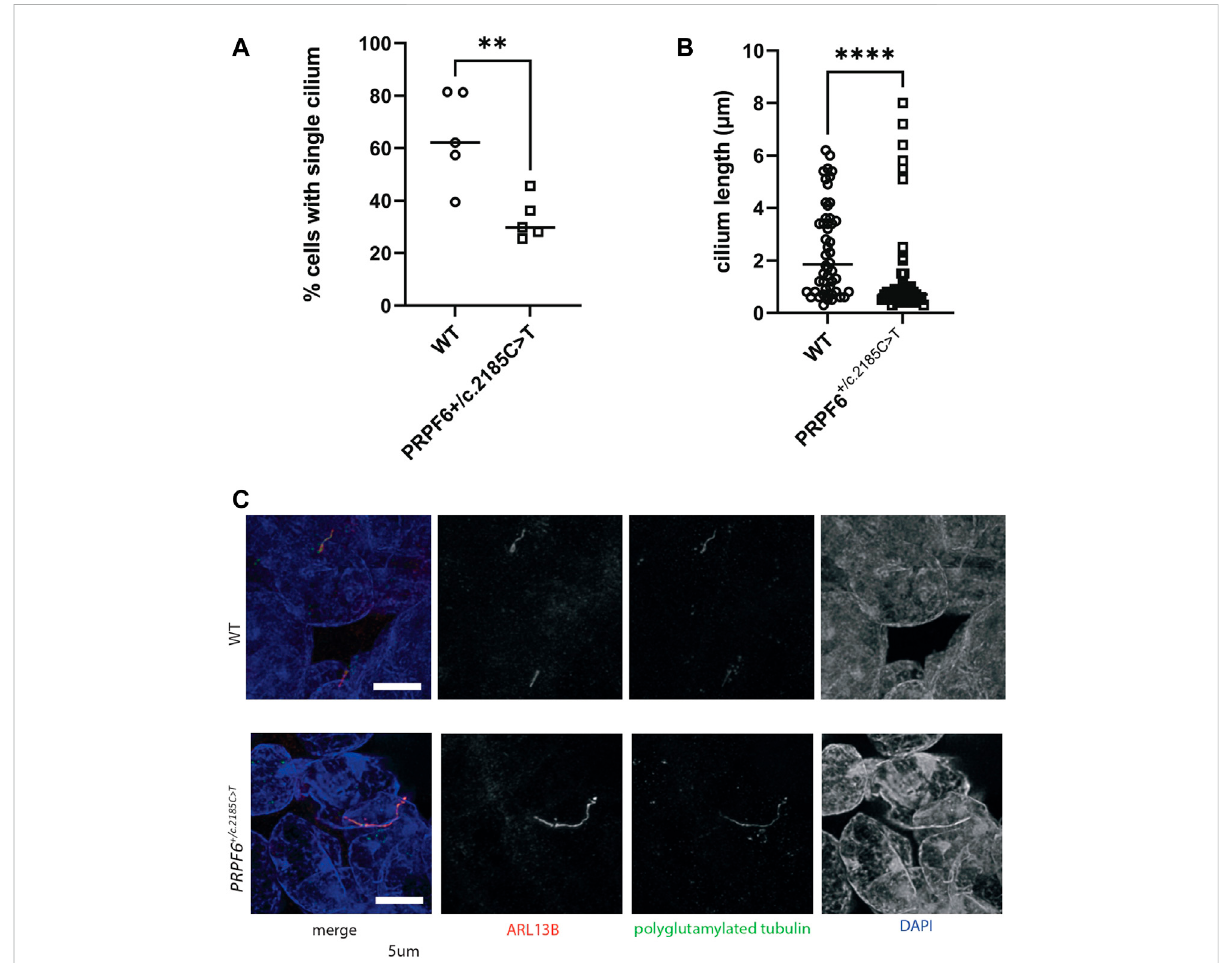
FIGURE 2 Quanti fi cationofciliaryphenotype in PRPF6 +/c.2185C > T base editedHEK293cells. (A) Dotplotofthepercentageofcells withasinglecilium inWT and PRPF6 +/c.2185C > T cells,showingastatisticallysigni fi cantreductioninthepercentageofcellswithasingleciliumin PRPF6 +/c.2185C > T cells.Two-tailed unpaired t test, p value0.0070,**= p < 0.005, t,dft=3.596, df=8.Onedatapointrepresentsdatafromonecoverslip(averagefrom6 fi eldsofview per coverslip, 5 coverslips, each coverslip is one independent experiment). (B) Dot plot of single cilium length in WT and PRPF6 +/c.2185C > T cells, showingastatisticallysigni fi cantreductioninciliumlengthin PRPF6 +/c.2185C > T cells.Two-tailedMannWhitneytest, p value < 0.0001(exact),****= p < 0.0001,SumofranksincolumnA,B3095,1955,Mann-WhitneyU680.Onedatapointrepresentsmeasurementofonecilium (measurementstaken from individual cilia across 6 fi elds of view per coverslip, each coverslip is one independent experiment). (C) Confocal image of PRPF6 +/c.2185C > T base edited HEK293 cells immunostained with anti ARL13B (red) and anti polyglutamylated tubulin (green) antibodies, showing the an example of